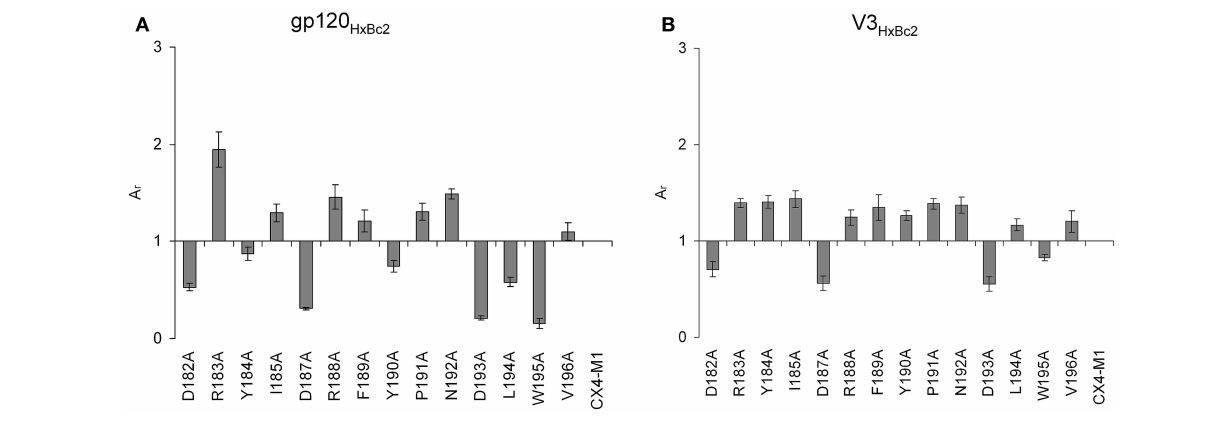
FIGURE 9 | Effect of alanine substitutions in ECL2 of CX4-M1 on binding to gp120 HxBc2 (A) (in the presence of sCD4) and its correspondingV3 loop peptide (V3 HxBc2 ) (B), respectively . See Section “Materials and Methods” (direct ELISA) for experimental detail.